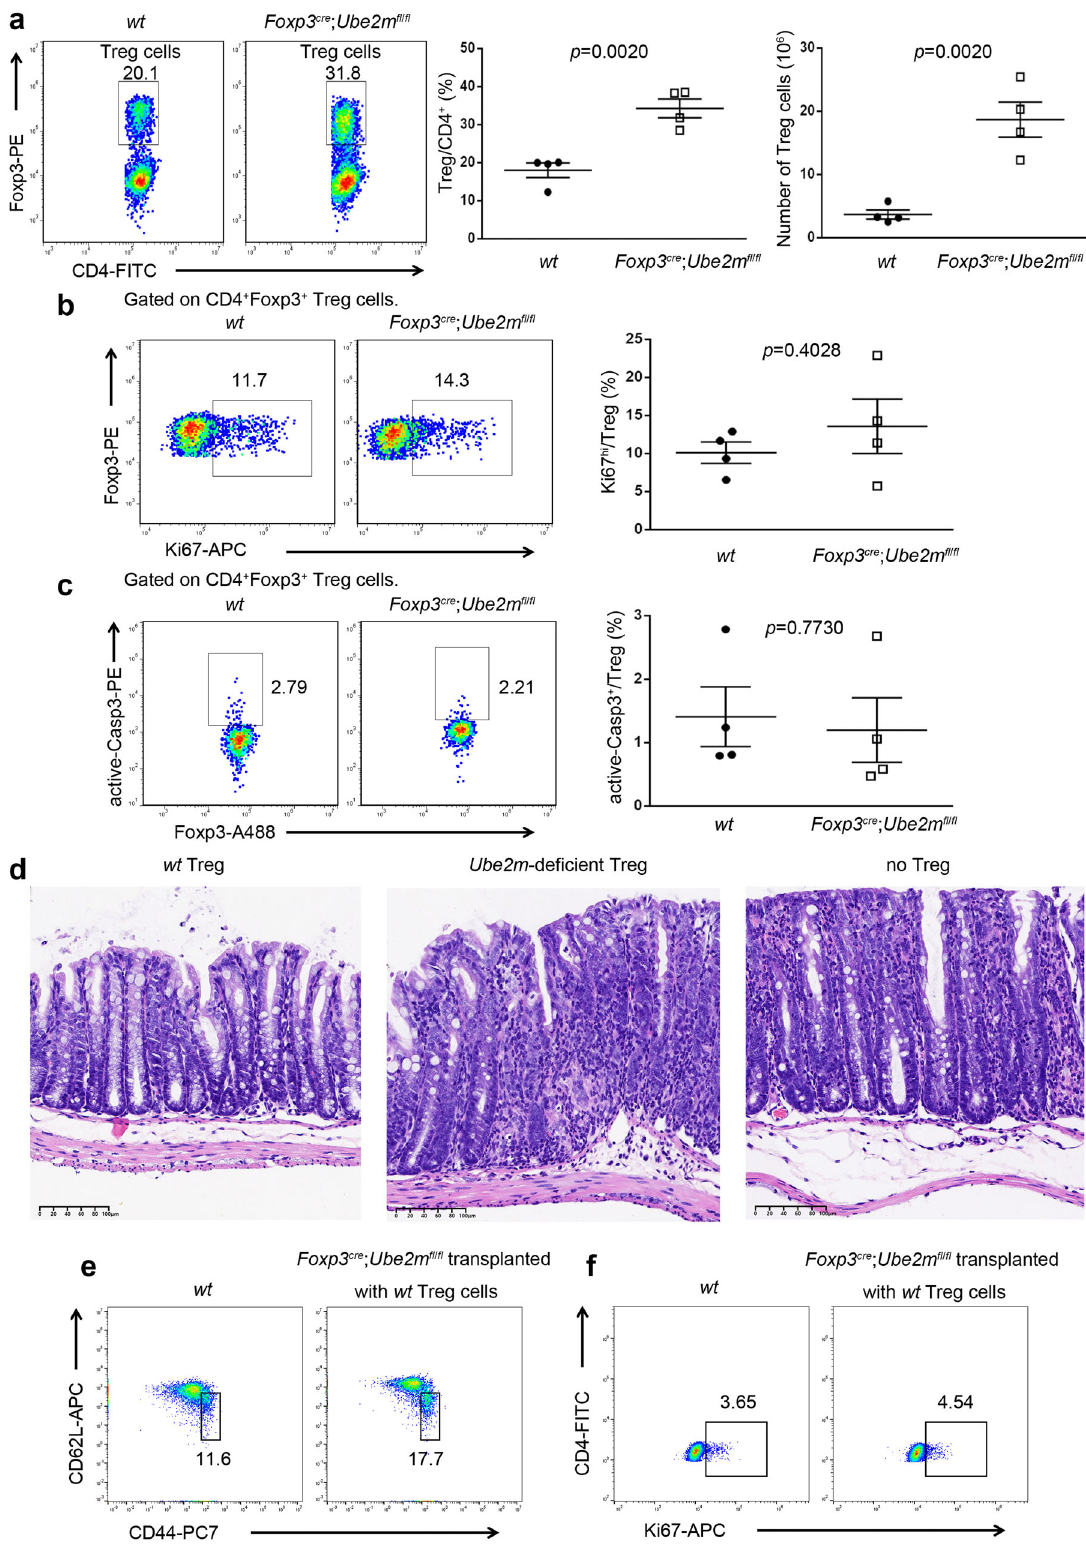
Flow cytometry . Peripheral lymph nodes and/or spleens were harvested from mice with indicated genotypes, and grinded into single cells, subjected to followed experiments. For analysis of surface markers, cells were washed in PBS containing 2% (wt/vol) FBS, and stained with indicated Abs (dilution 1: 200); intracellular markers were strained with Transcription Factor Buffer Set (BD Pharmingen, 562574) according to the manufacturer ’ s instructions by indicated Abs (dilution 1: 50). For intracellular cytokine staining, cells were stimulated for 5 h with